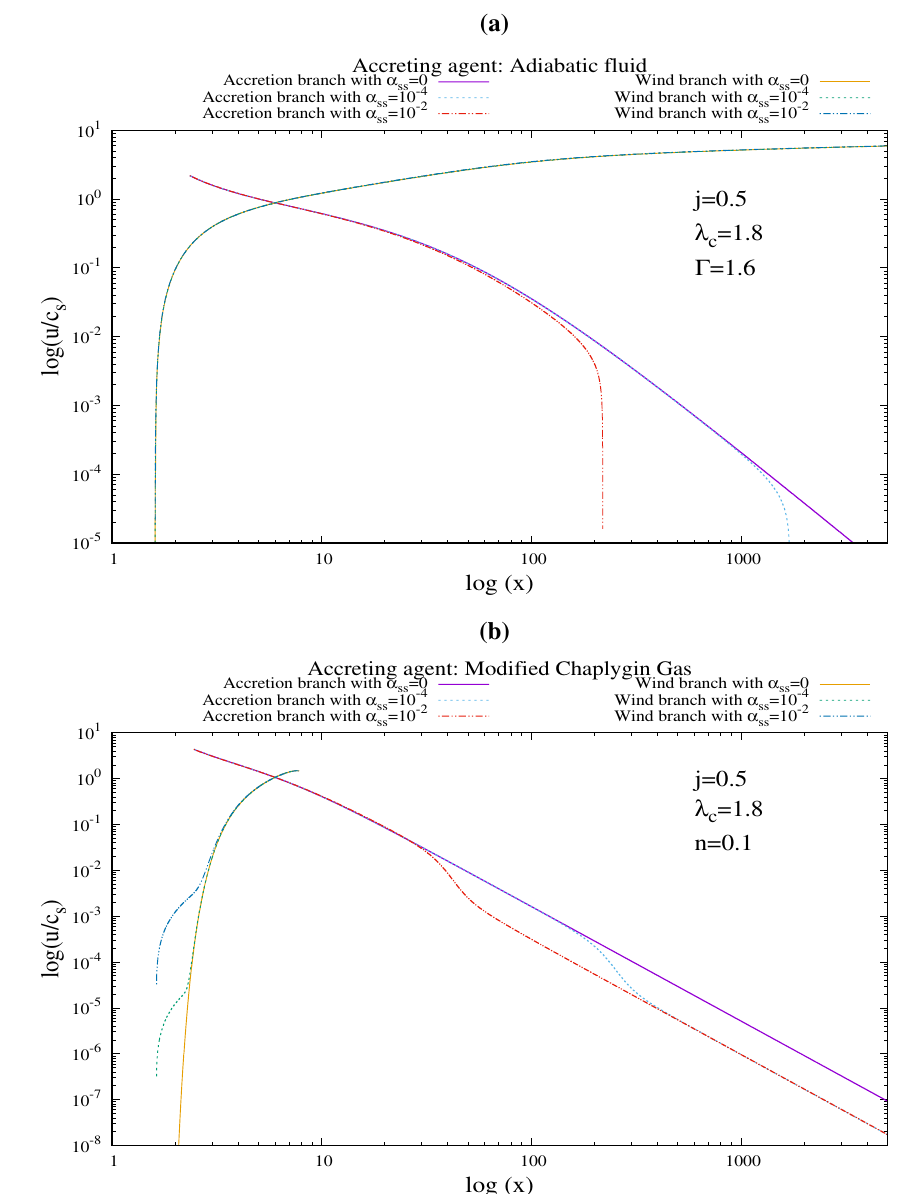
Accreting agent: Adiabatic fluid Accretion branch with α ss =0 Accretion branch with α ss =10